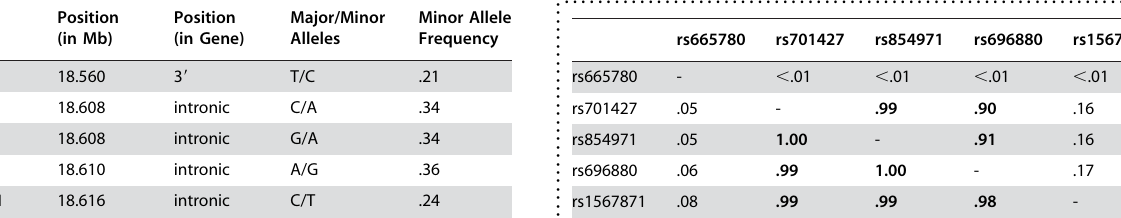
(LAMP) analysis ( Table 3 ) on the combined sample also provided no evidence for unequal allelic transmission. In a sex-stratified analysis, SNP rs696880 showed the most significant association in females (Sch1: RR A = 0.74, P = .064; Sch2: RR A = 0.73, P = .046)